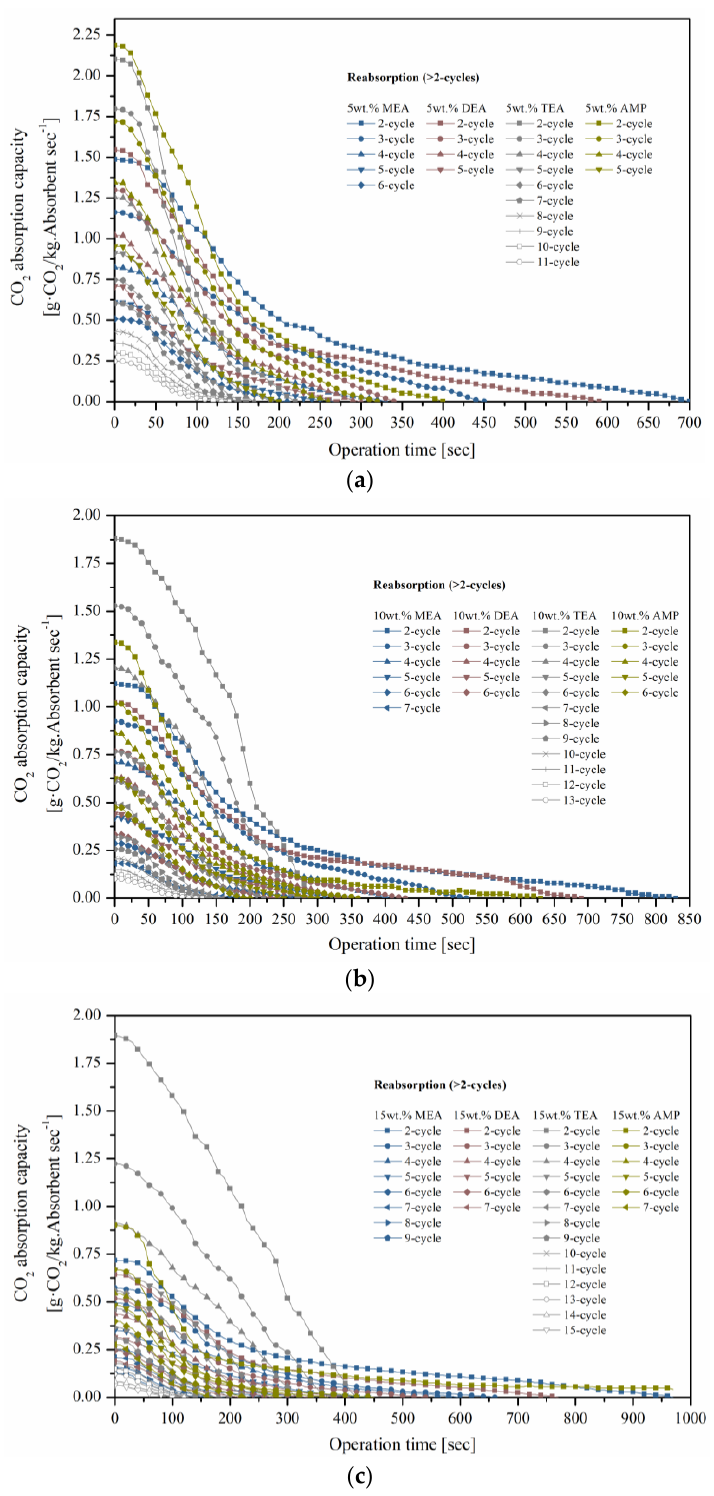
Figure 6. CO 2 absorption rates at ( a ) 5, ( b ) 10, and ( c ) 15 wt.% aqueous MEA, DEA, TEA, and AMP in >2 cycles of multicycle IAM. The rate was evaluated by the amount of absorbed CO 2 in every 10 s (Table S1 – S12).